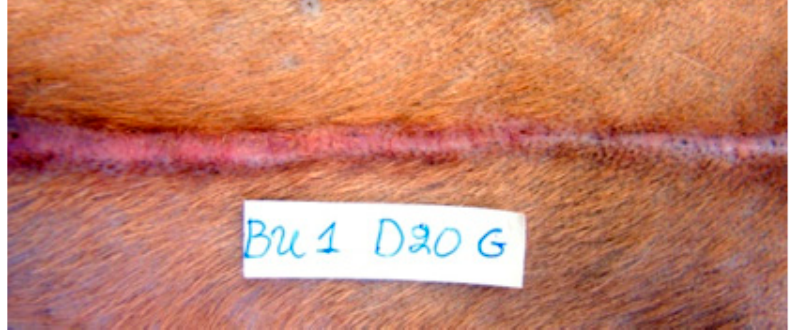
Figure 4. Erythema at the wound area closed with glue 20 days postoperatively.